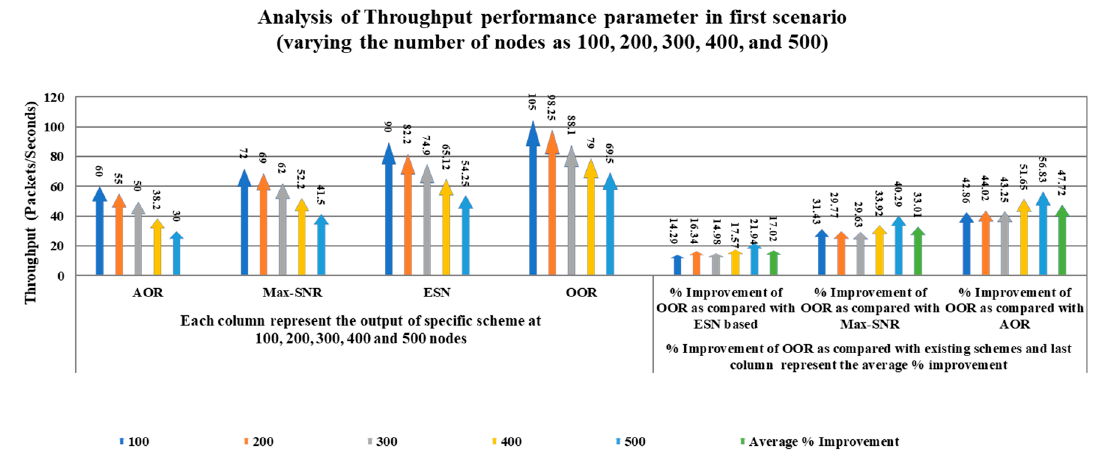
Figure 9. Detailed performance reflection of OOR with throughput parameter.